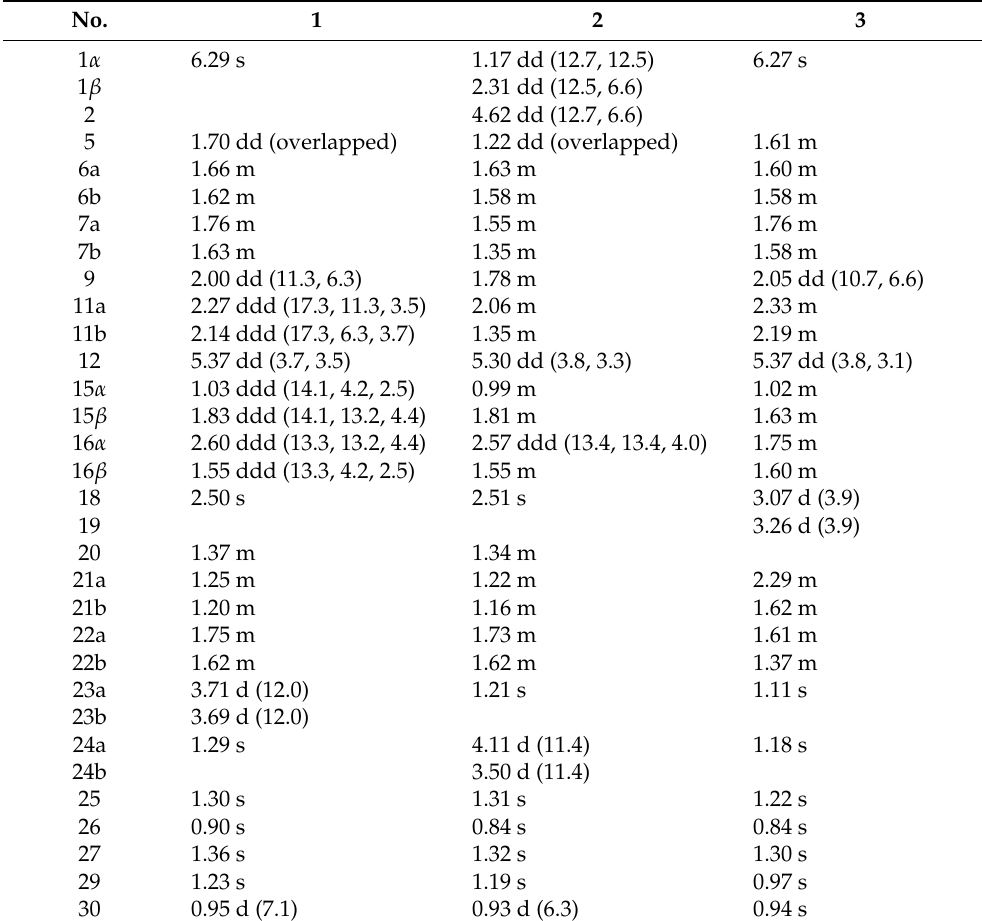
Table 2. 1 H NMR data a ( δ in ppm, J values in Hz, 600 MHz) of 1 − 3 in CD 3 OD.